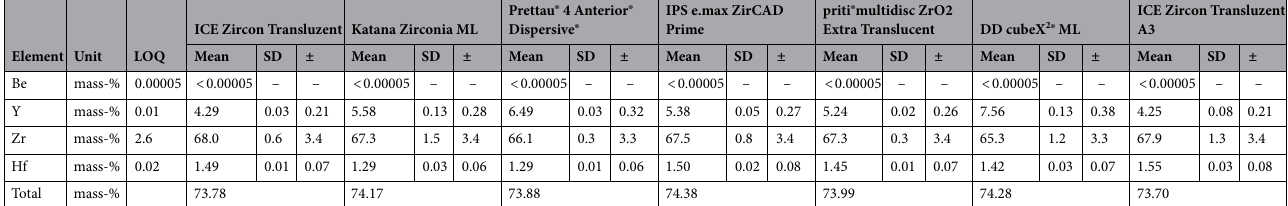
Table 6. ICP-OES results of oxide ceramics. LOQ limit of quantitation, SD standard deviation, ± : measurement